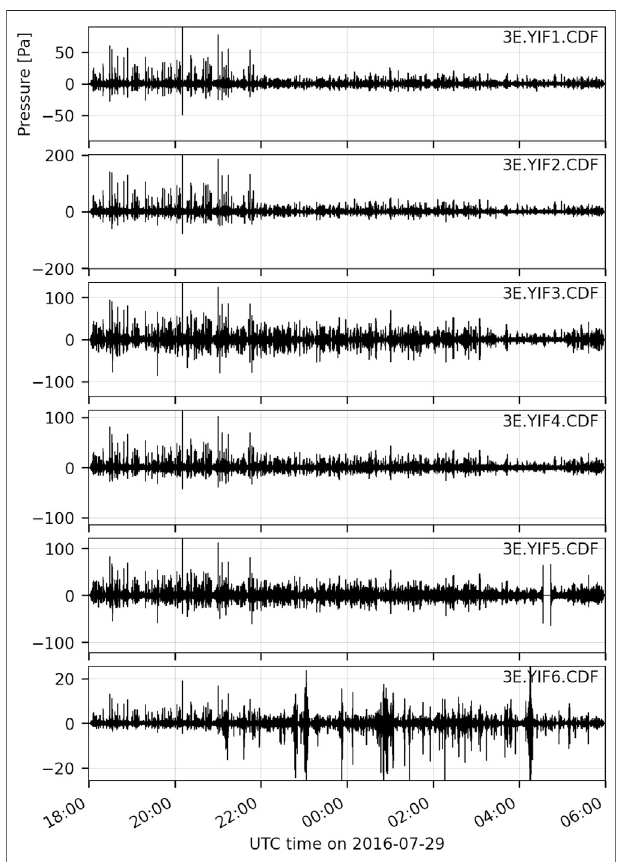
FIGURE 5 | Filtered infrasound waveforms for a 12 h period at Yasur. Near-continuous explosions are visible across the infrasound network. The fi rst 4 h contain the highest amplitude explosions. Wind is present on YIF6 for the last 8 h. A short data outage occurs at YIF5 around 05:00 UTC.